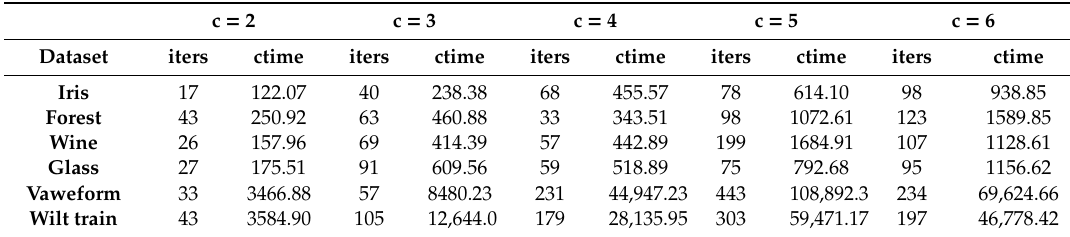
Table 7. Performance of the kmpp algorithm on the real datasets.